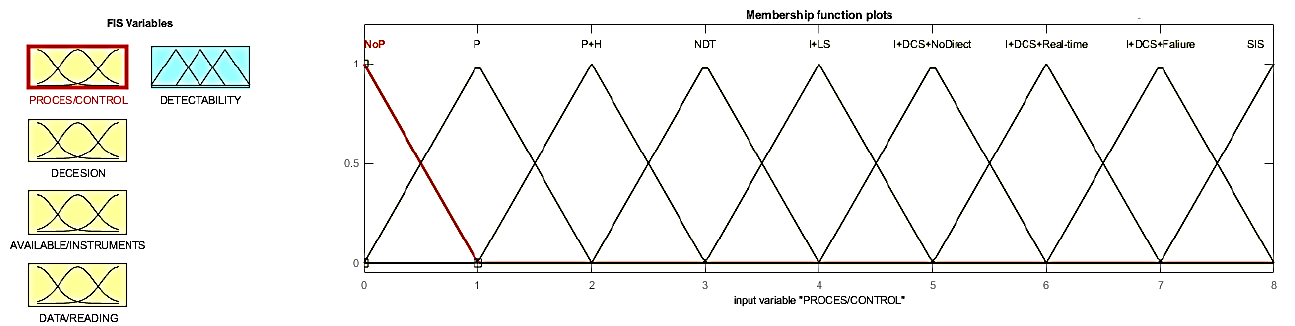
Figure 3. The input of the process control membership function plot.